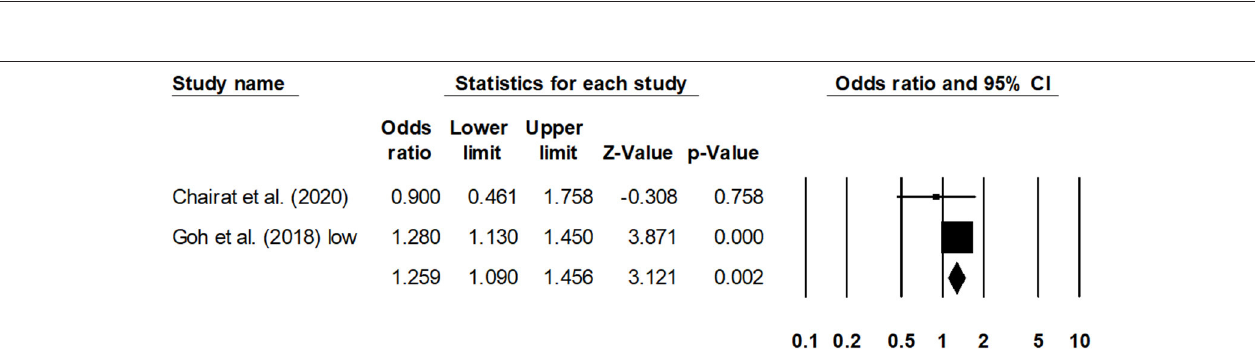
FIGURE 6 | Forest plot for studies evaluating the overall 1-year overall mortality outcome for HF patients with reduced ejection fraction. The adjusted odds ratios are presented as black boxes, whereas 95% confidence intervals are presented as whiskers. A negative odds ratio represents a reduction in the risk of mortality in heart failure patients with anemia, whereas the positive odds ratio represents an increase in the risk of mortality in heart failure patients with anemia.